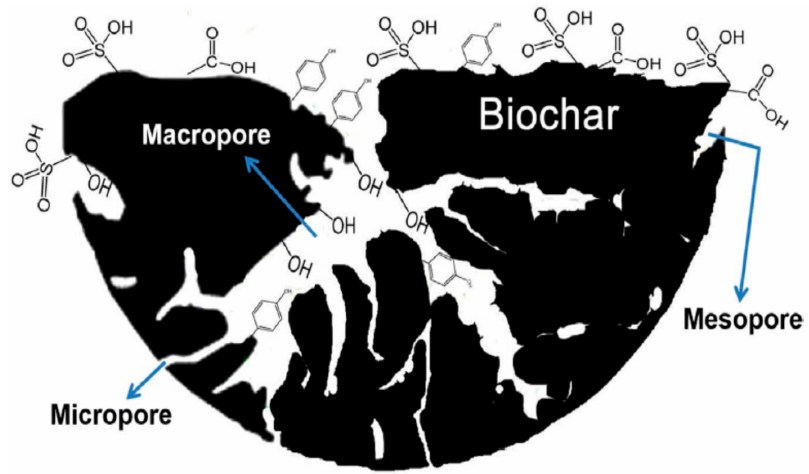
Figure 8. Schematic of porous biochar containing various functional groups. Reprinted with permission from Reference [11]. Copyright (2017) Elsevier